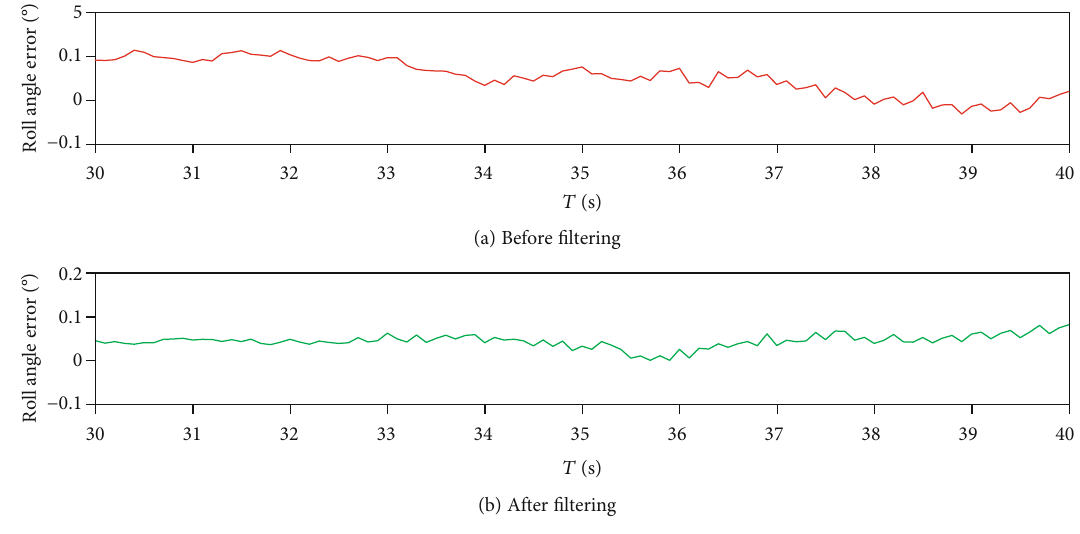
Figure 10: Comparison of roll angle error in fl ight time between 30 s and 40